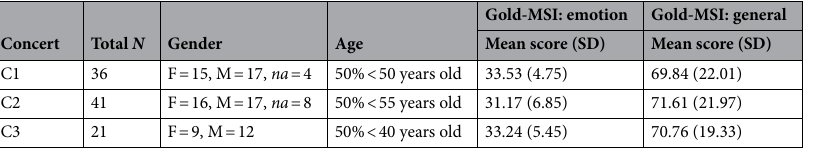
Table 5. Demographic information about participants in the current study, showing distribution of age, gender, and musical sophistication (general and emotions) across concerts. Participants were asked to report their age by selecting age group (within a 5-year range from 18 to 99, i.e., 18–22, 23–27, 28–32, etc.).